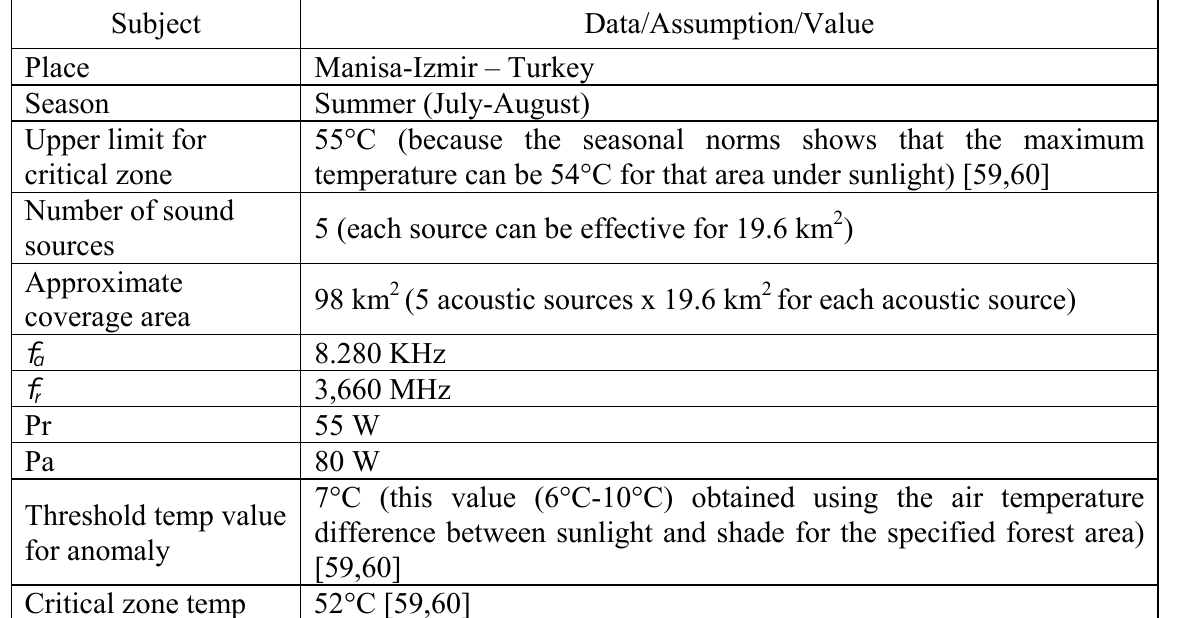
Table 2. Simulation environment